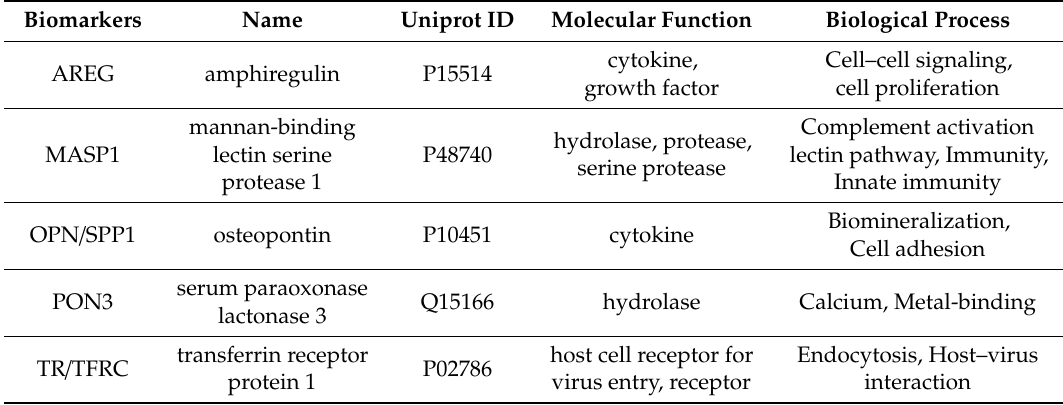
Table 4. Functions of proteins from the identified five-marker